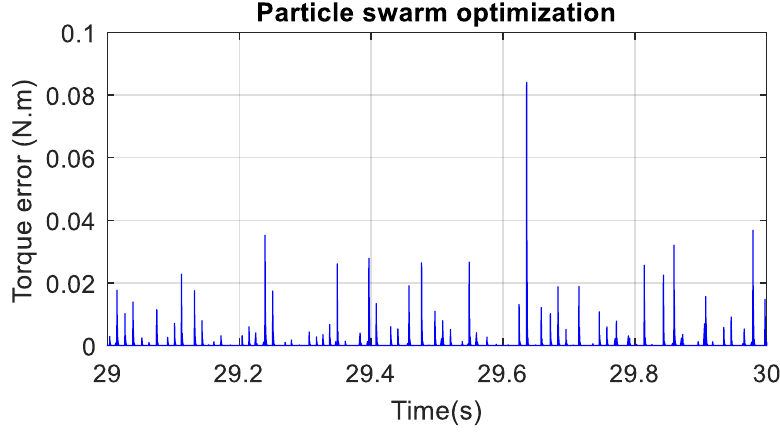
Figure 22. BEV absolute torque error with PSO. Figure 23 highlights the cost value for PSO and GA algorithms while minimizing the fitness function J 1 given in Equation (37). One can notice the cost value for both algorithms keeps decreasing as the number of iterations increases, which mean that the used-cost function was effectively optimized. From Figure 23, moreover, one can remark that both algorithms converged to the same value, although GA converged faster.